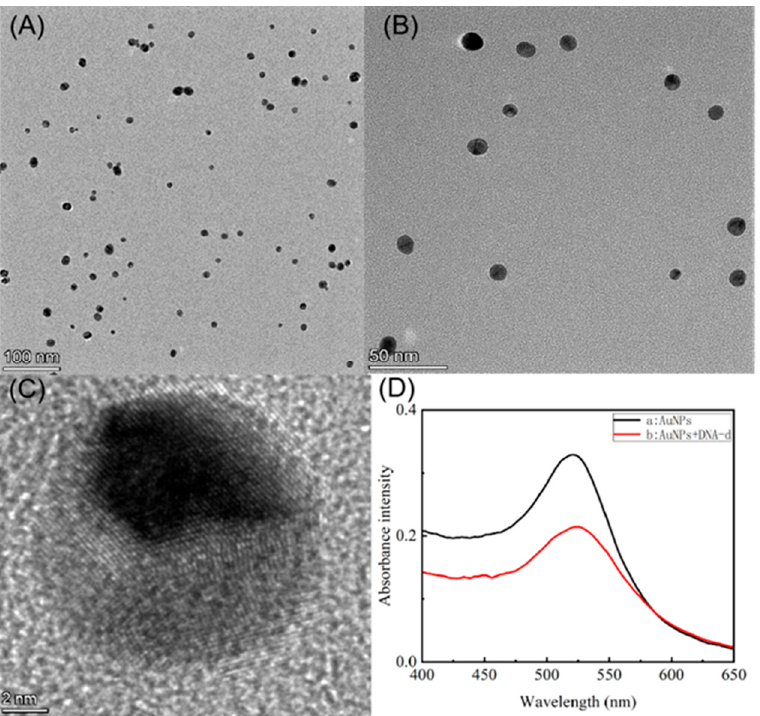
Figure 2. ( A – C ) TEM images of the AuNPs ( A , B , and C show the TEM images at 100 nm, 50 nm, and 2 nm, respectively); ( D ) UV spectra of AuNPs (black curve a) and AuNPs–DNA (red curve b), with curve b red-shifted by 3 nm with respect to curve a.